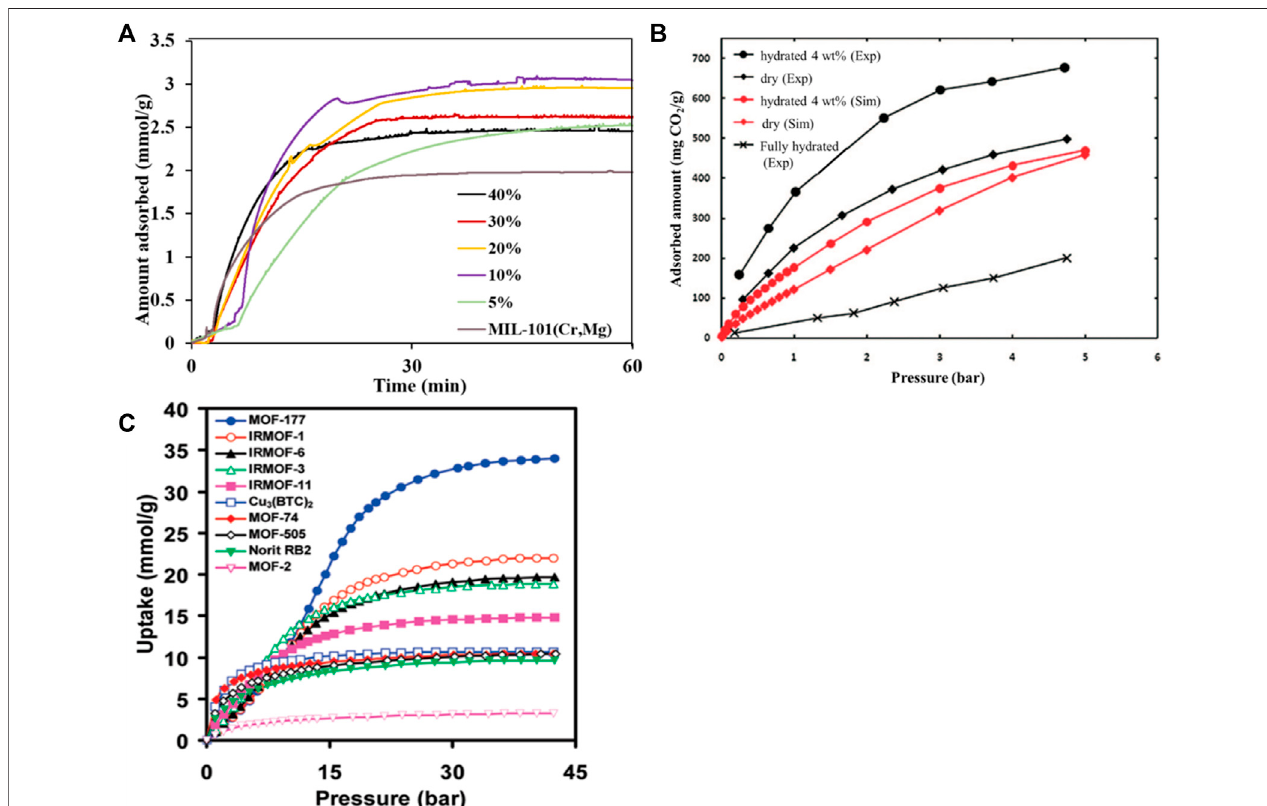
FIGURE 5 | The selective absorption of CO 2 by MOFs: (A) the effect of PEI loading on the adsorption selectivity of MIL-101 (Cr, Mg) adsorbent (Gaikwad et al., 2019); (B) the adsorption selectivity of HKUST-1 for CO 2 /H 2 O (Yazayd ı n et al., 2009) ( (C) the adsorption properties of MOF-177 and Cu-BTC under different pressures (Millward and Yaghi,